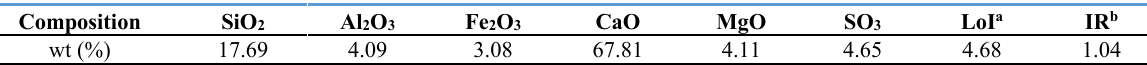
Table 1. Chemical composition of Portland